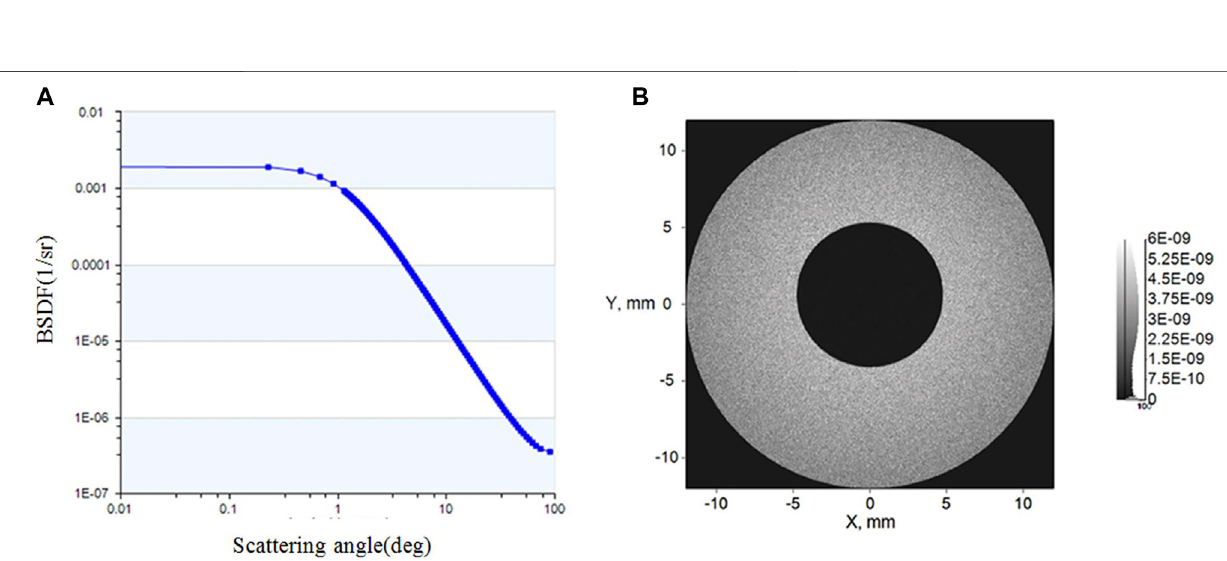
Frontiers in Physics |